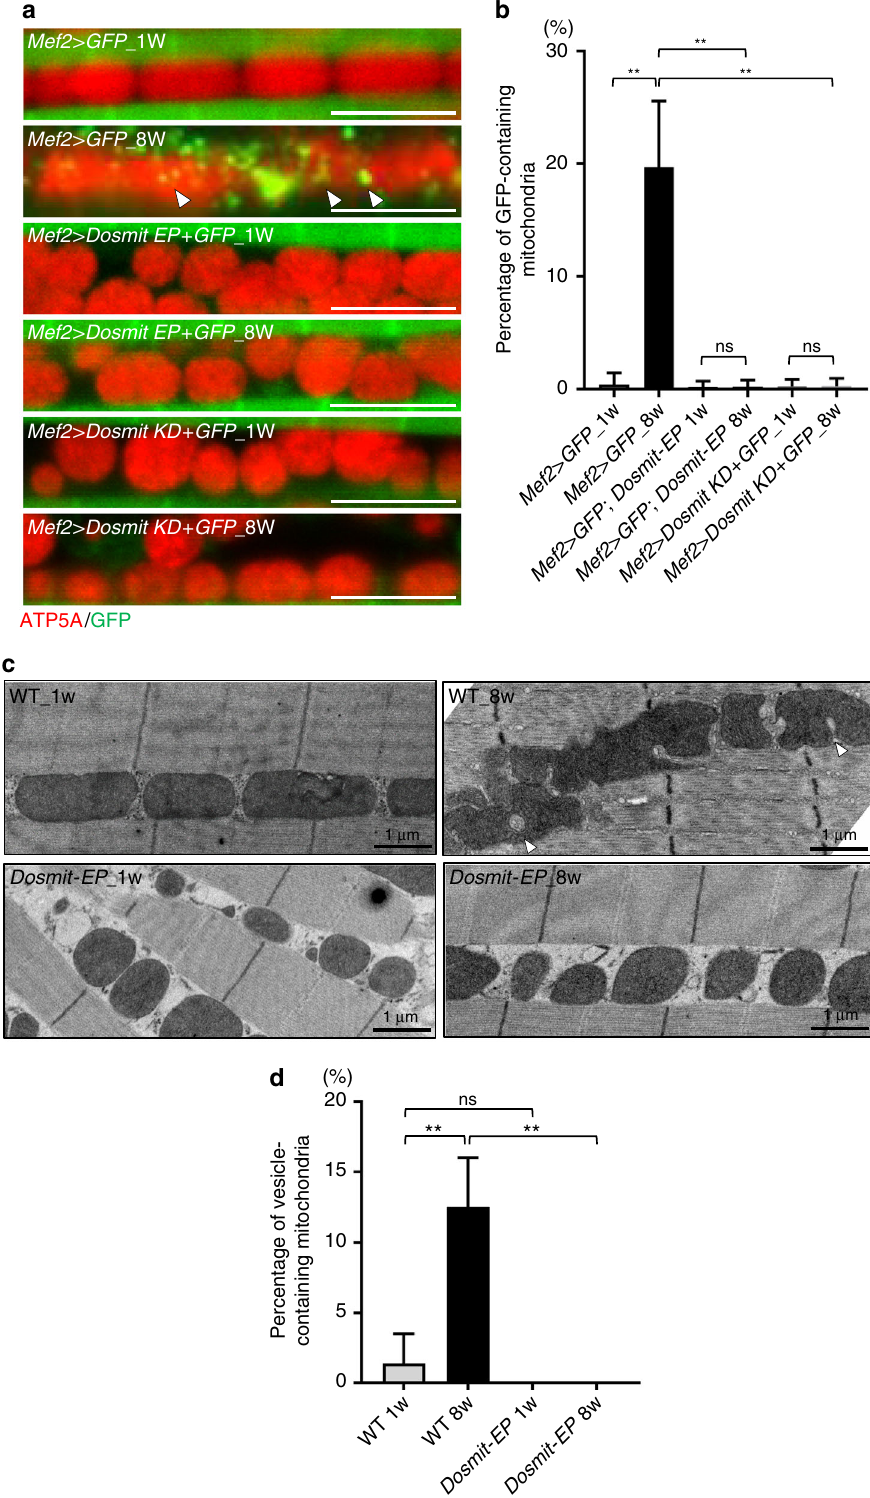
Fig. 7 Aged mitochondria exhibit internalization of cytosolic content, but no vesicles appear in aging Dosmit-EP fl ies. a Comparison of mitochondrial size in control ( Mef2 > GFP ) and Mef2 > Dosmit-EP + GFP and Mef2 > Dosmit KD + GFP fl ies (aged either 1 or 8 weeks) containing cytosolic GFP (arrowheads). Scale bars: 5 μ m. b Percentage of wild-type mitochondria containing GFP in Mef2 > GFP , Mef2 > Dosmit KD + GFP and Mef2 > Dosmit EP + GFP fl ies aged 1 or 8 weeks (mean± SD). N = 397, 340, 407, 400, 328, and 328 from left to right bars. Statistical test: Two-tailed Mann – Whitney U- test (** p < 0.01, ns: p > 0.9999). c TEM images of vesicle-containing mitochondria in wild-type and Dosmit-EP mutant fl ies (aged either 1 or 8 weeks) compared with a 1-week-old fl y. d Percentage of vesicle-containing mitochondria in wild-type and Dosmit-EP mutant fl ies aged 1 or 8 weeks (mean ±SD). N = 143, 125, 162 and 169 from left to right bars. Statistical test: Two-tailed Mann – Whitney U- test (** p < 0.01; ns: p = 0.4545). Source data are provided as a Source Data fi